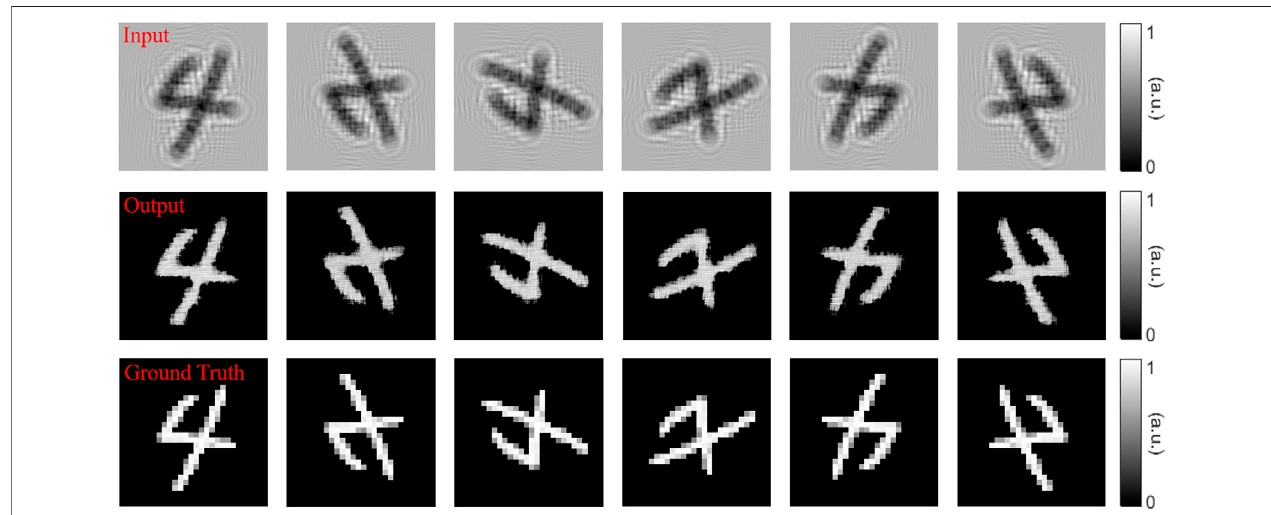
FIGURE4| Acoustichologramreconstructedresultsfortherotatedtargetimagesofdigit4whichareusedtoevaluatetherobustnessofPhysNet-AH.The fi rstrow showsthediffractedacoustic fi eldintensityfromthehologramoftherotatedimagesof4atz=10 mm.Thesecondrowshowsthecorrespondingreconstructionresults. The last row shows the target images (ground